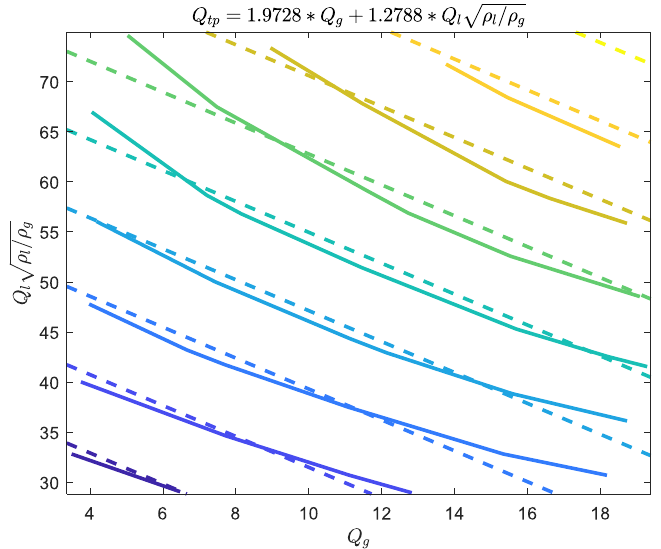
Figure 10. The fitting results of the indicated gas flowrate 𝑄 𝑡𝑝 of the “DP + Cap” method. It can be noted from Equation (16) that it can either be written as 𝑄 𝑡𝑝 = 𝑄 𝑔 (𝛽 0 + 𝑋) = 𝑄 𝛽 𝜙 1 𝑔 𝑔 or written as